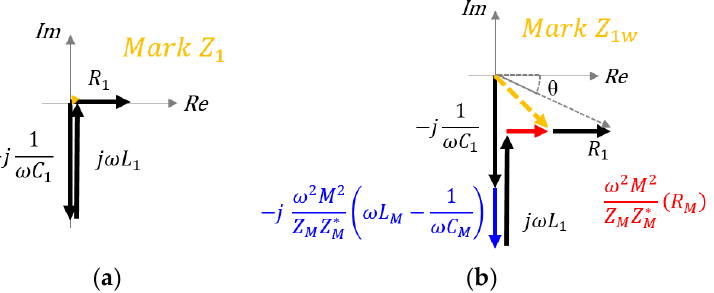
Figure 4. Phasor diagram of the impedance. ( a ) in the absence of a metallic object (MO). ( b ) in the presence of the MO. Figure 4a indicates that the impedance Z 1 = j ( ω L 1 − 1/( ω C 1 ) at node 1 is zero